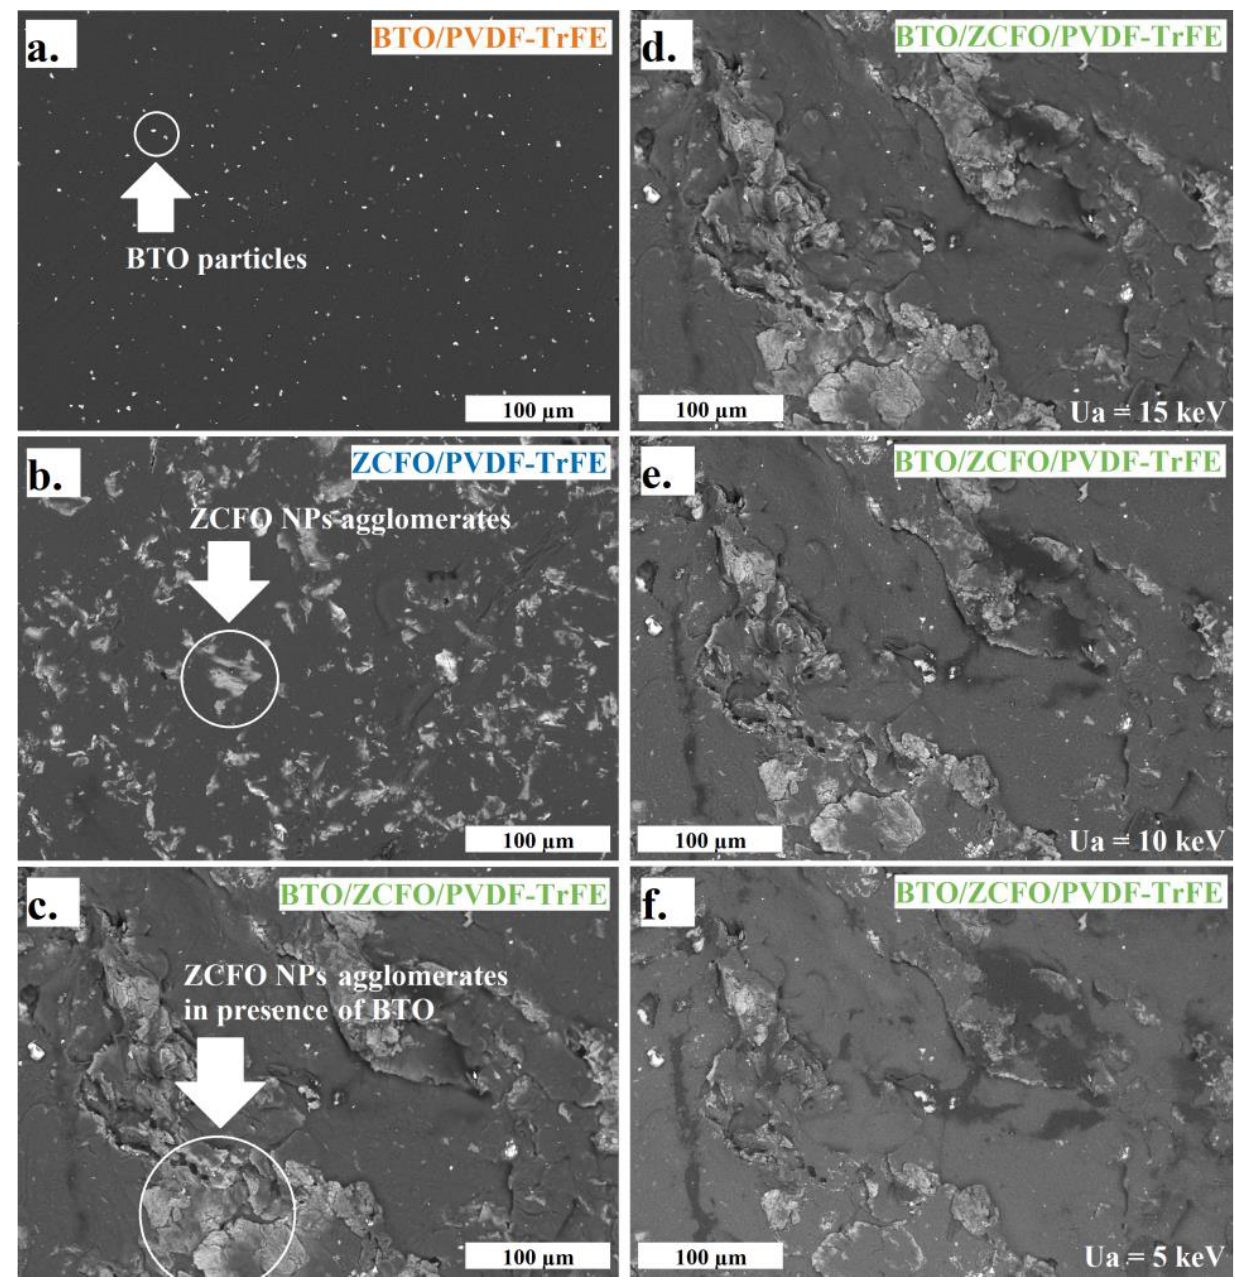
Figure 3. SEM (BSE) micrographs of BTO/PVDF-TrFE ( a ), ZCFO/PVDF-TrFE ( b ) and BTO/ZCFO/PVDF-TrFE ( c , d ) samples under U a = 15 keV; the same area of BTO/ZCFO/PVDF-TrFE sample under U a = 10 keV ( e ) and U a = 5 keV ( f ); the sale bar is the same for all the panes.